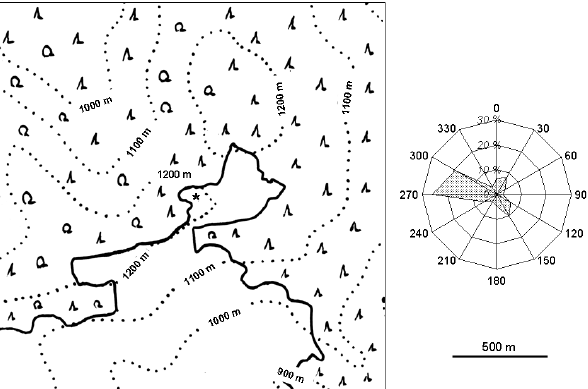
Fig. 1. Left: sketch of topography and forest cover (solid line in- Figure 1: (left) Sketch of topography and forest cover (solid line indicates forest edge) around the measurement station (asterisk in the exact centre) in the Black Forest. (right) dicates forest edge) around the measurement station (asterisk in the Frequency distribution of wind directions for 30 o sectors during the observation period. Wind exact centre) in the Black Forest. Right: Frequency distribution from the sector 120° - 180° is considered to have been least influenced by vegetation. of wind directions for 30 ◦ sectors during the observation period. Wind from the sector 120 ◦ –180 ◦ is considered to have been least influenced by vegetation.